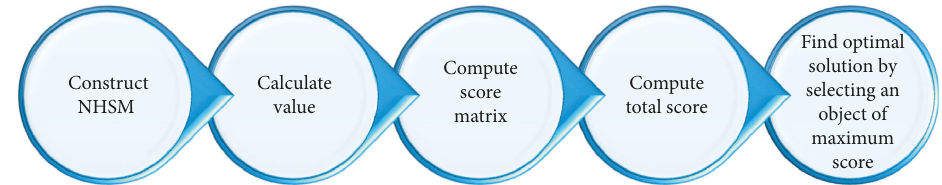
Figure 1: Flowchart of the proposed